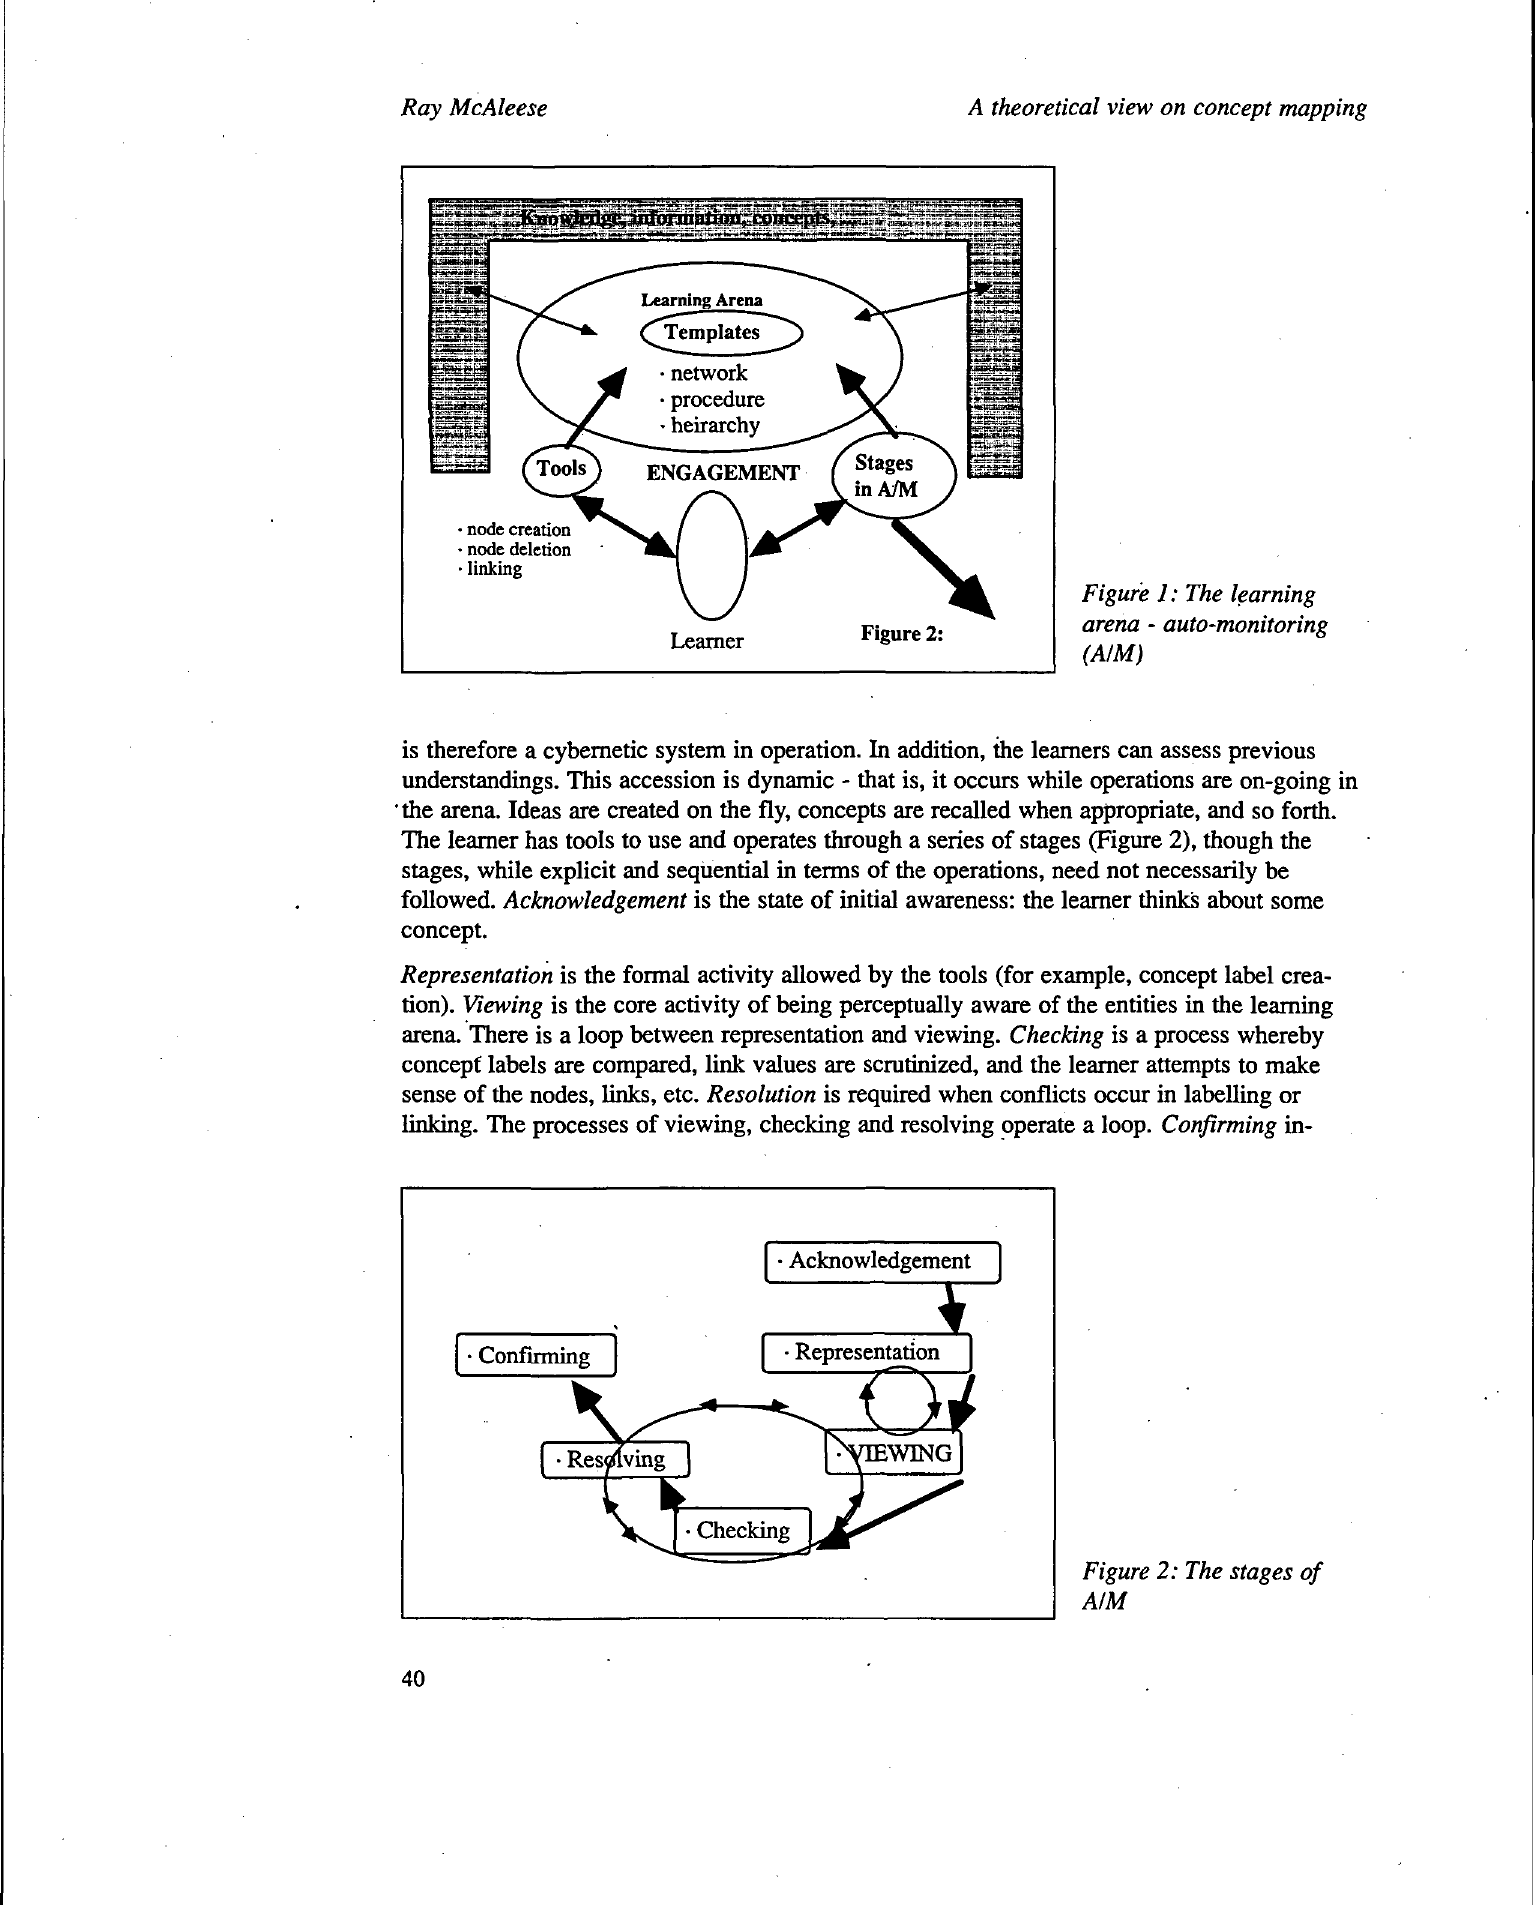
Figure 2: The stages